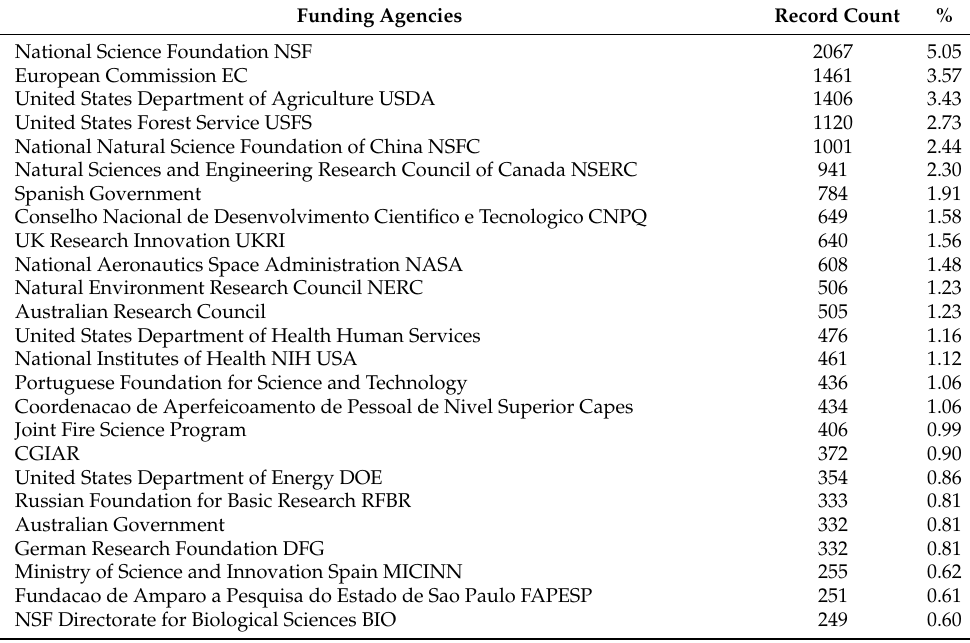
Table 2. Agencies funding studies on forest fire